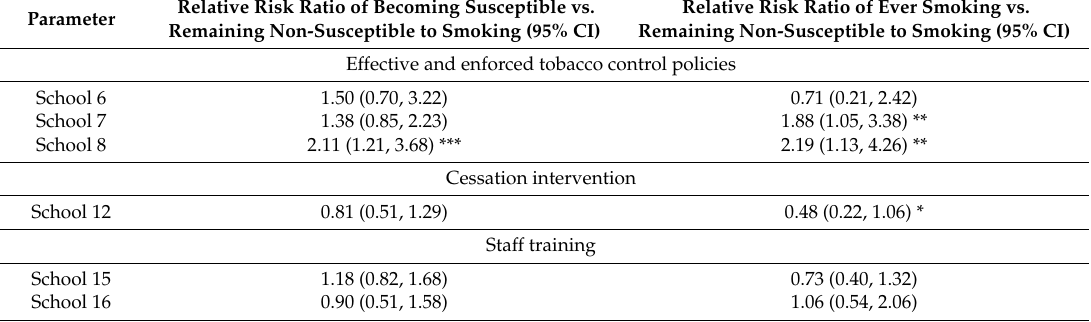
Table 2. Multinomial logistic regression analyses (Model 1) evaluating the impact of six school-specific tobacco interventions implemented between baseline and follow-up among baseline non-susceptible never smokers, 2012–2014 COMPASS study, Ontario, ON, Canada. Relative Risk Ratio of Ever Smoking vs. Remaining Non-Susceptible to Smoking (95% CI)